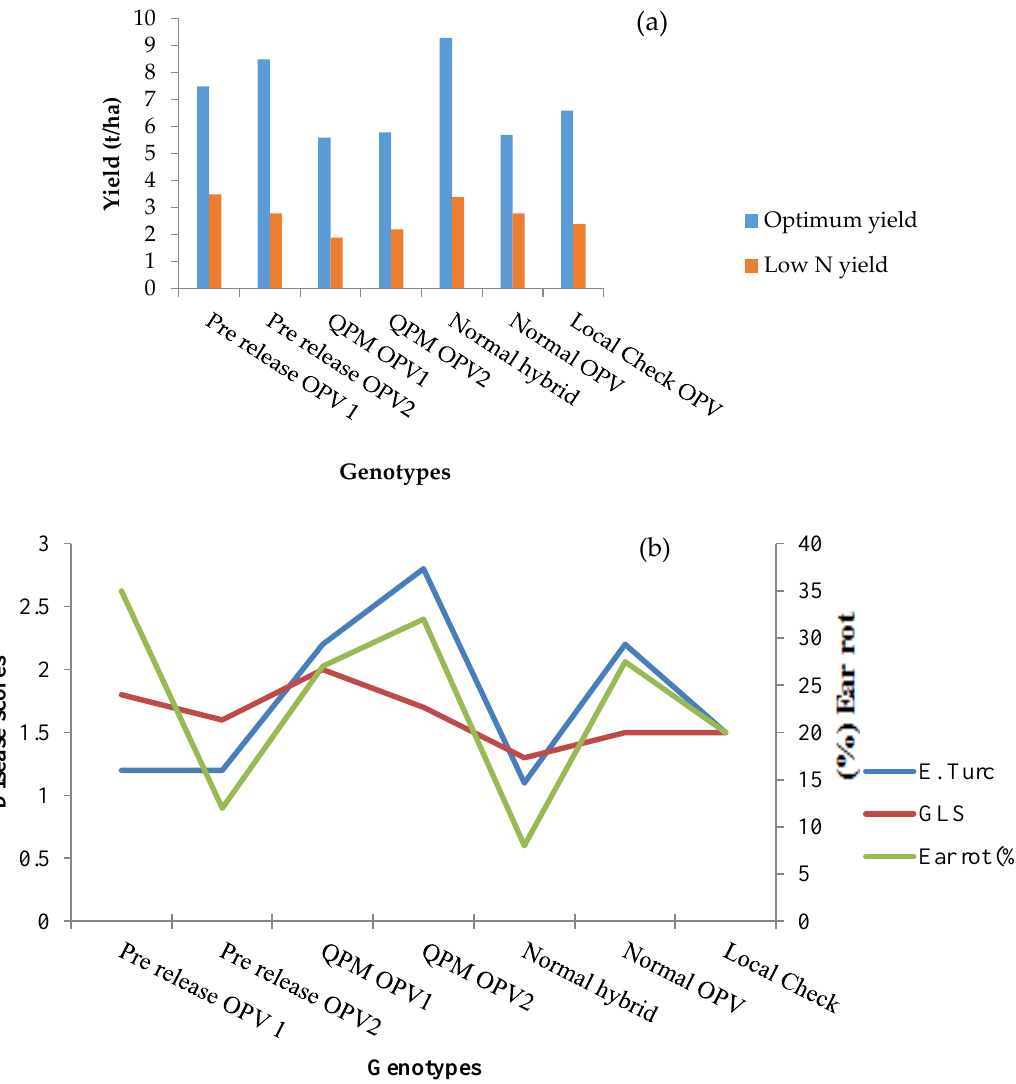
Figure 1. Grain yield (t/ha) ( a ), and disease ( b ) (GLS, Turcicum leaf blight and ear rot) reaction of two QPM OPVs, two prerelease QPM hybrids, two normal OPV S and one normal hybrid, tested in 2003 across four sites including low N and optimum soil conditions in Kenya (adapted from [14]).